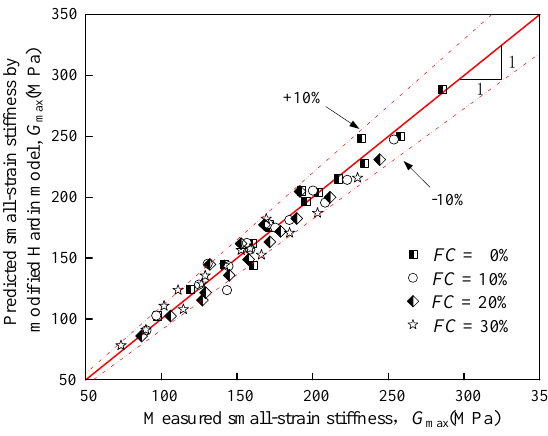
Figure 9. Comparison of the measured G max and the predicted G max using the modified Hardin model.